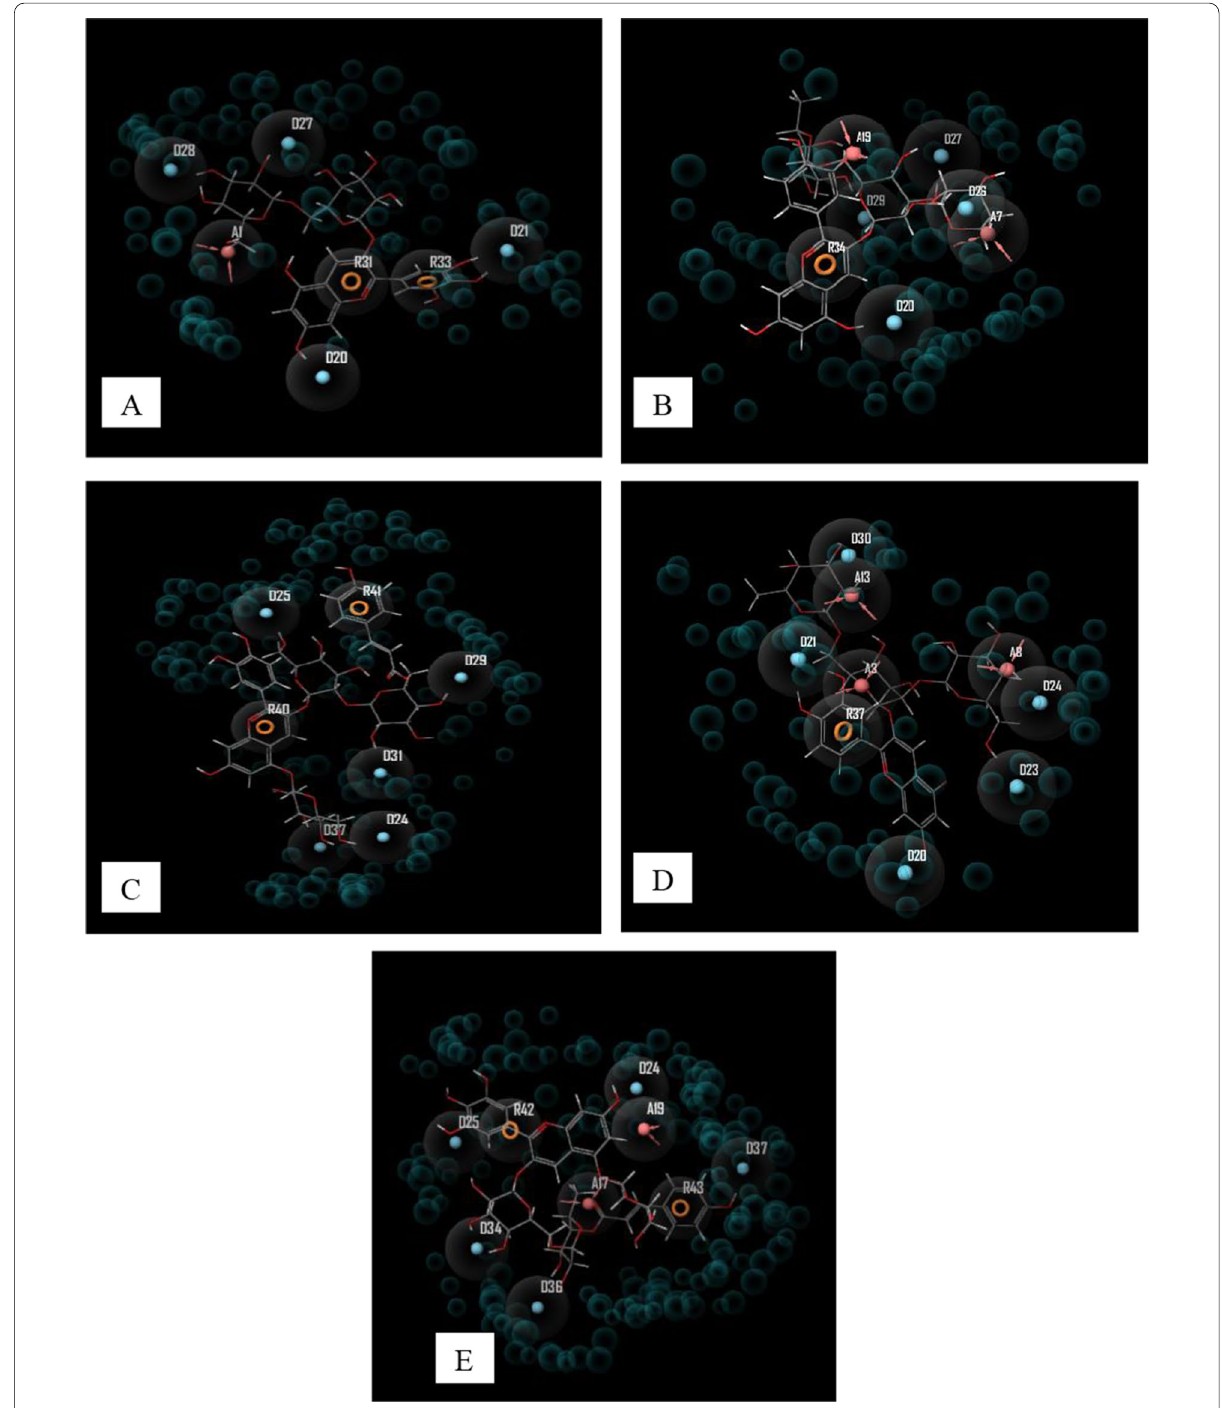
Fig. 2 Pharmacophore model of top-scoring compounds. A polymerase complex, D